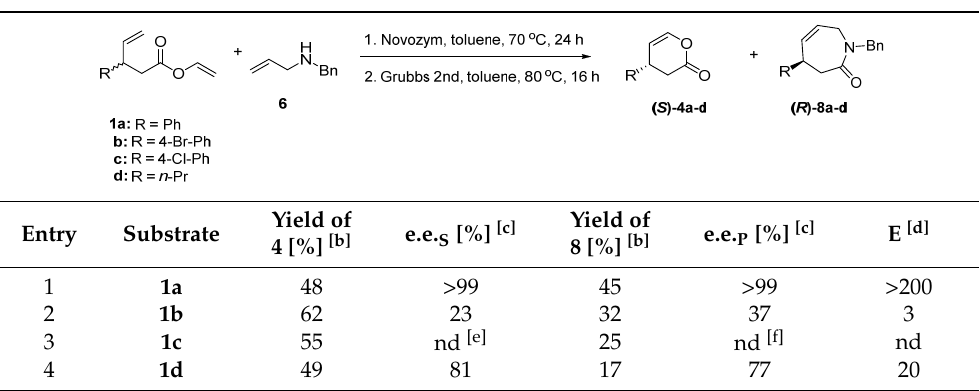
Table 5. One ‐ pot two ‐ step synthesis of lactones 4 and lactams 8 [a] Table 5. One-pot two-step synthesis of lactones 4 and lactams 8 [a] .